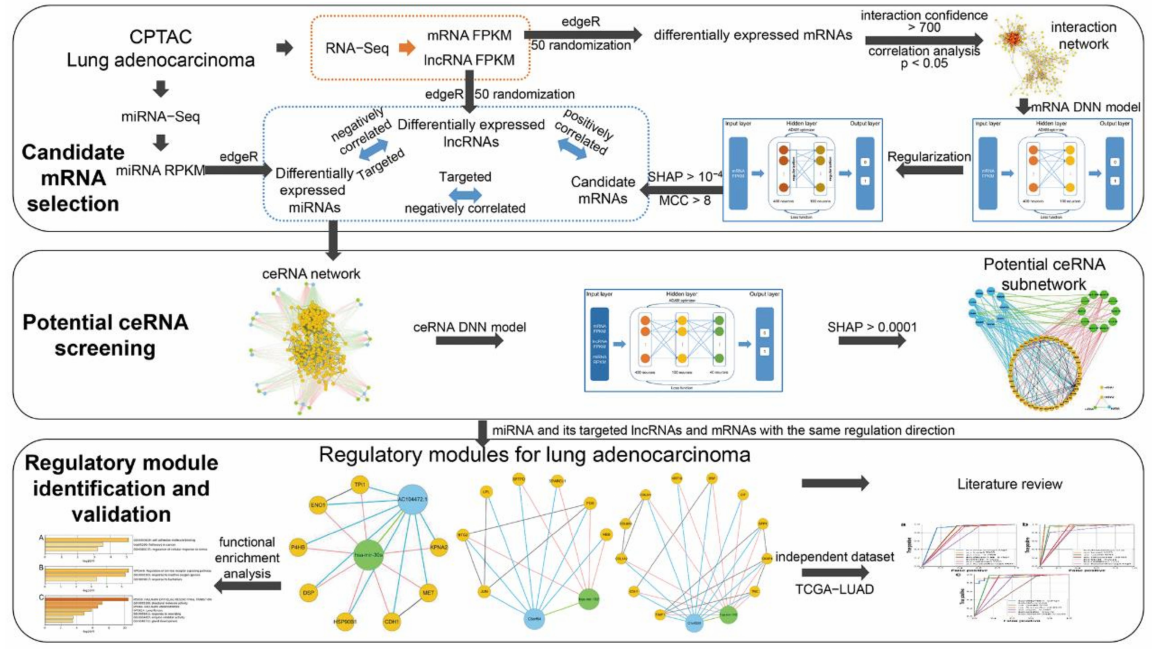
Figure 1. The workflow of this study. Firstly, expression data of mRNAs, miRNAs and lncRNAs were